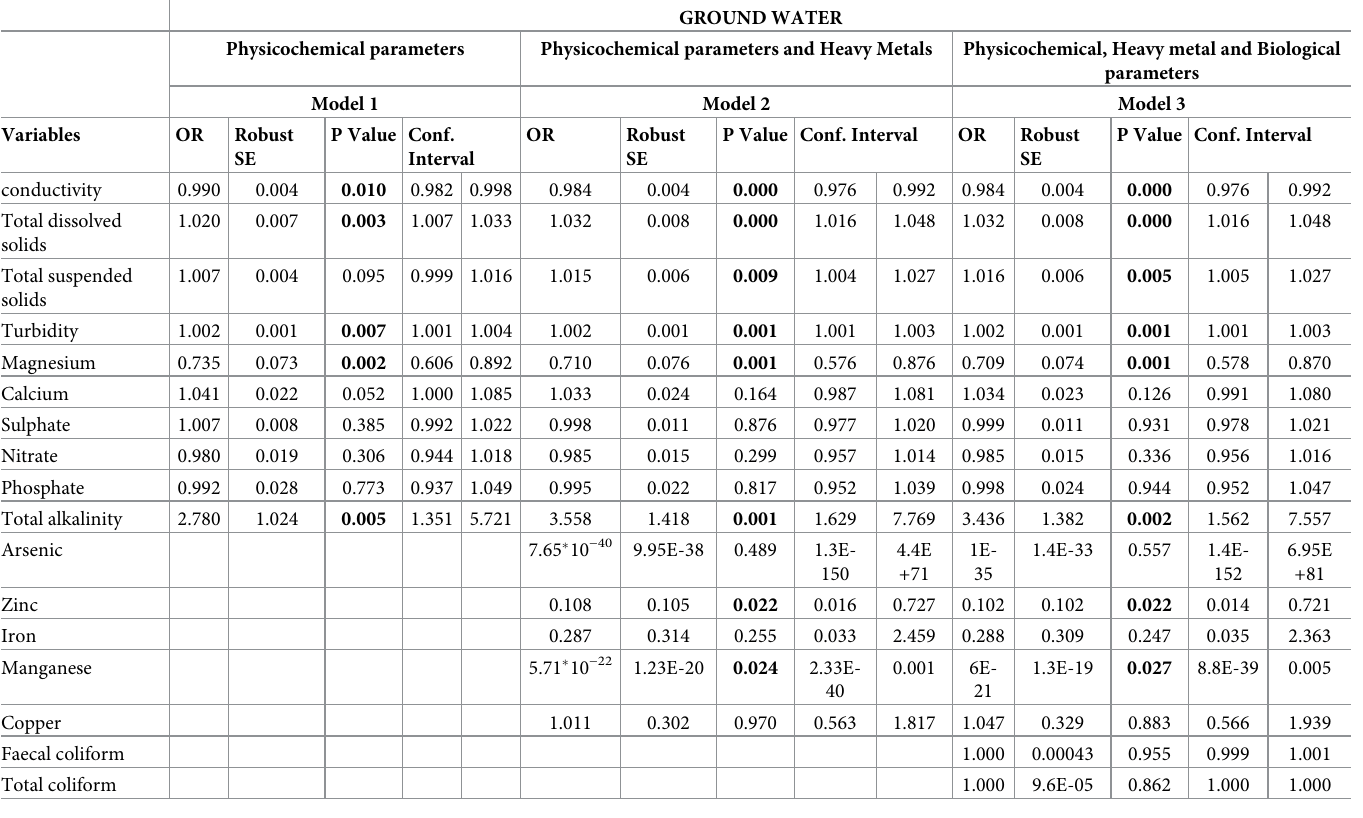
Table 5. Multivariate complementary log–log regression model predicting the relationship between pH and water quality parameters for